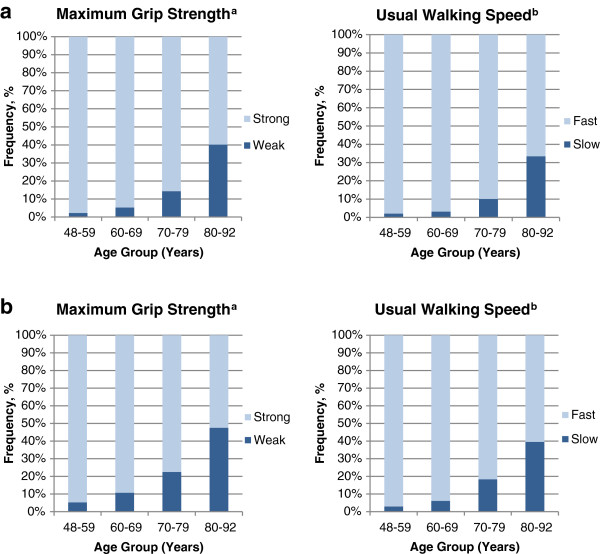
The range of physical capability within 10-year age groups in men (2a) and women (2b). aWeak participants had grip strengths of <30 kg (men) or <20 kg (women). bSlow participants had a usual walking speed of ≤0.8 m/s.